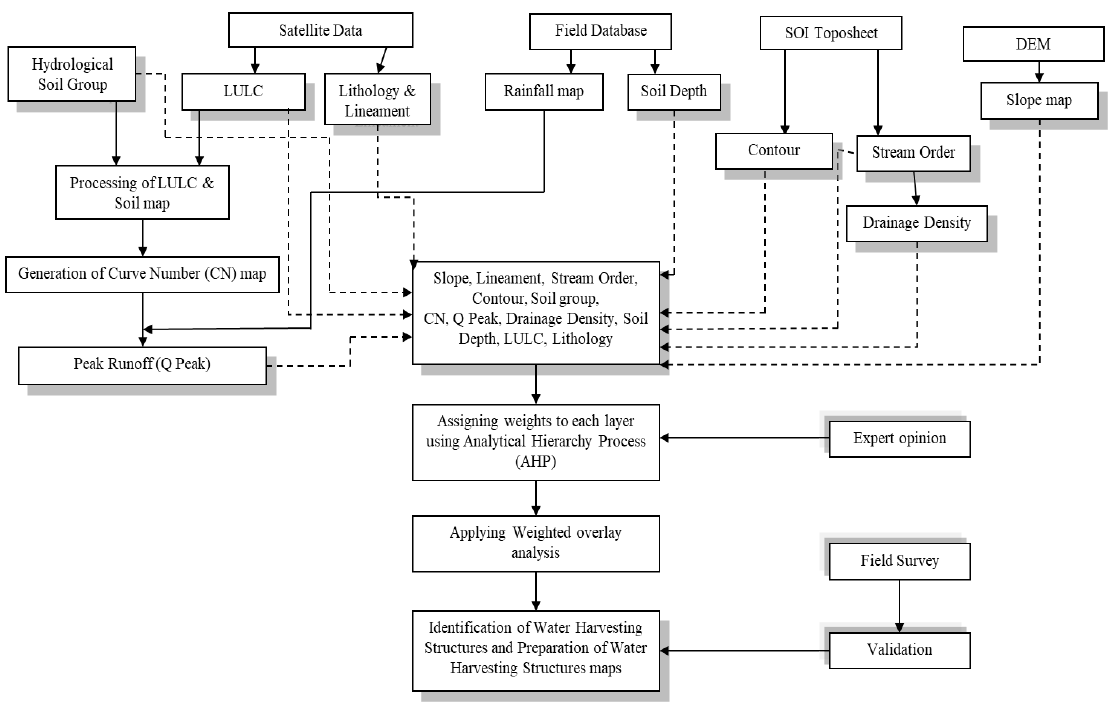
Figure 3: Flowchart of